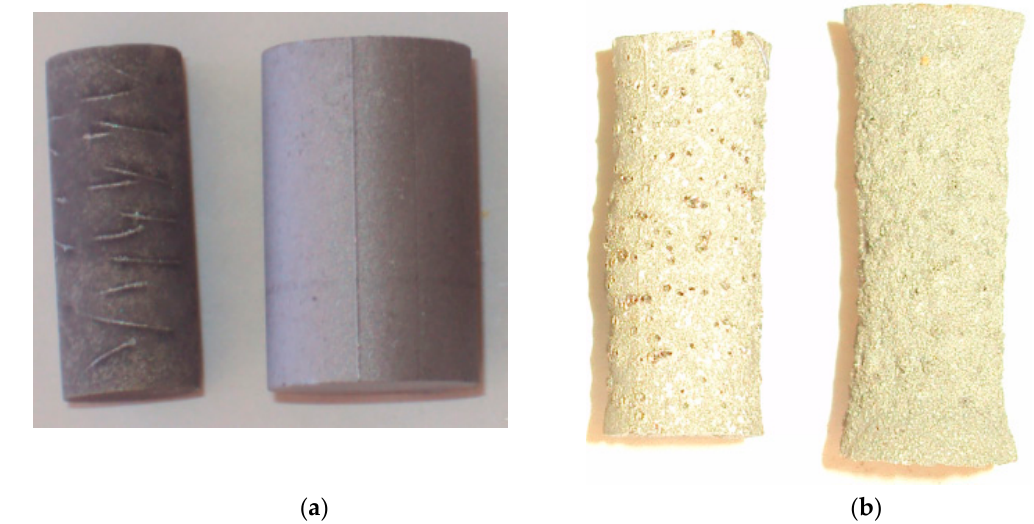
Figure 3. Surface conditions of Ti 4 AlN 3 (left) and Ti 2 AlN (right) before ( a ) and after ( b ) thermal decomposition in vacuum.